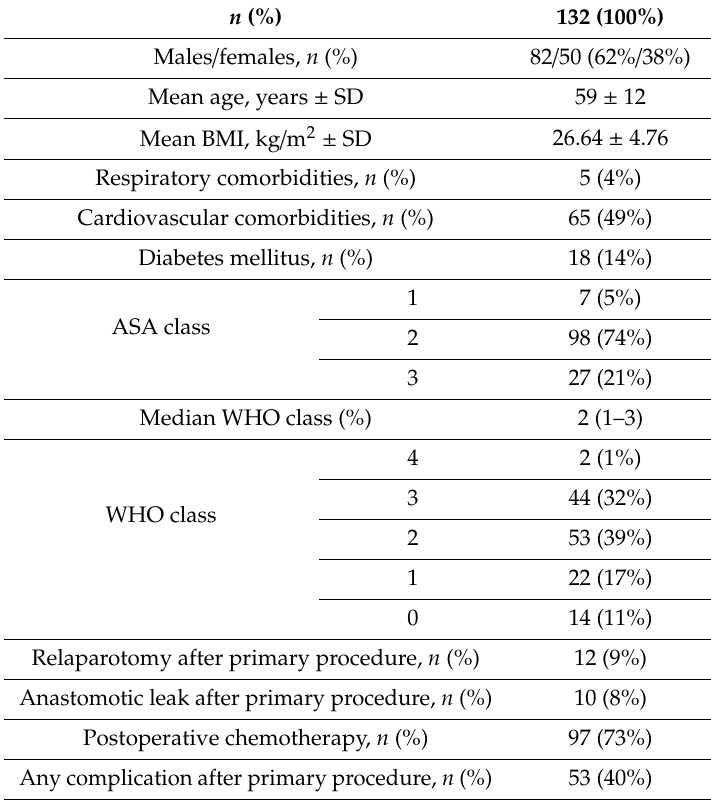
Table 1. Basic characteristics of the patients regarding primary procedure.